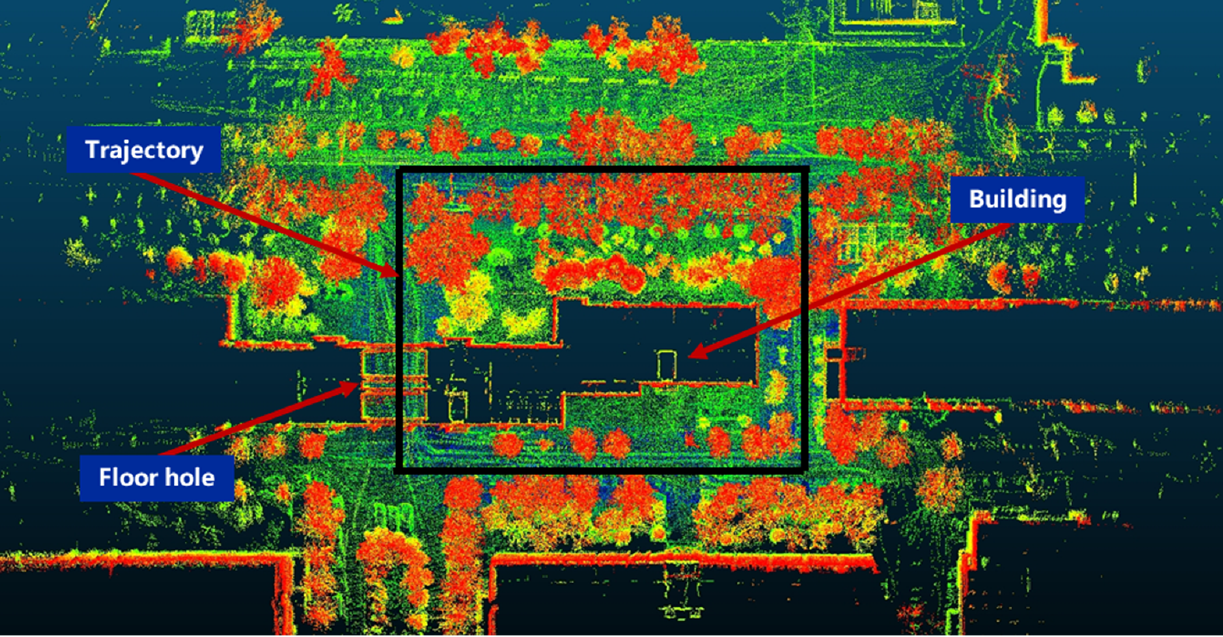
Figure 17. Three-Dimensional LiDAR global point cloud map in case two.